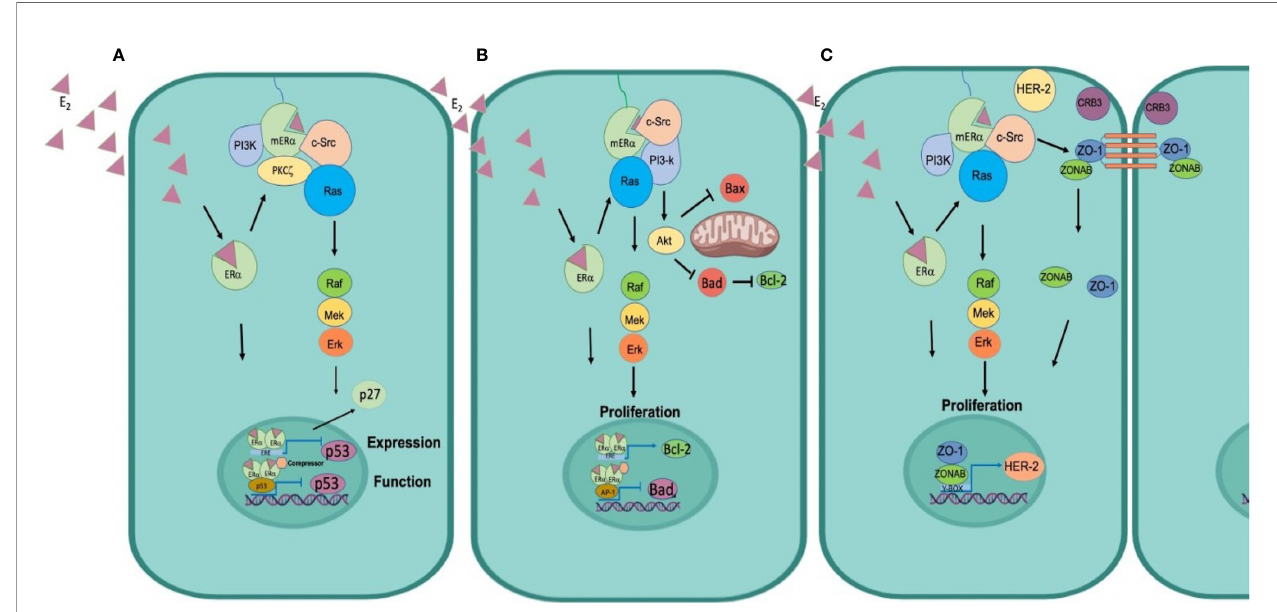
FIGURE 3 | Mechanisms of estrogen-induced resistance and signaling of its receptors. (A) Control of the cell cycle. ER functions as a transcription factor to regulate p53 expression, in addition ER can physically interact with p53 to inhibit p53 function. Moreover, it signals through the c-Src kinase and switches on the PI3K and Ras/MAPK pathways to promote activation of Cyclin D and release the p27 repressor from the nucleus to promote cell cycle progression. (B) Inhibition of apoptosis ER functions as a transcription factor to induce the expression of the anti-apoptotic protein Bcl2 and functions as a transcriptional co-repressor of Bad to inhibit its synthesis. Furthermore, mER a associates with c-Src, to activate the PI3k/Akt pathway, Akt phosphorylates Bad to preclude the formation of Bad/Bad homodimer and block the release of cytochrome C and thus the process of apoptosis. (C) Cellular plasticity promotes TEM. E2 diffuses through the plasma membrane binds to mER, induces phosphorylation of c-Src, its associated with ZO1, and forms the p-Src/ZO-1 complex, that favors the dissociation of the Tight Junctions and promotes that ZO1 and ZONAB are translocated to the nucleus, inducing the transcription of HER-2, which triggers EMT and migration of tumor